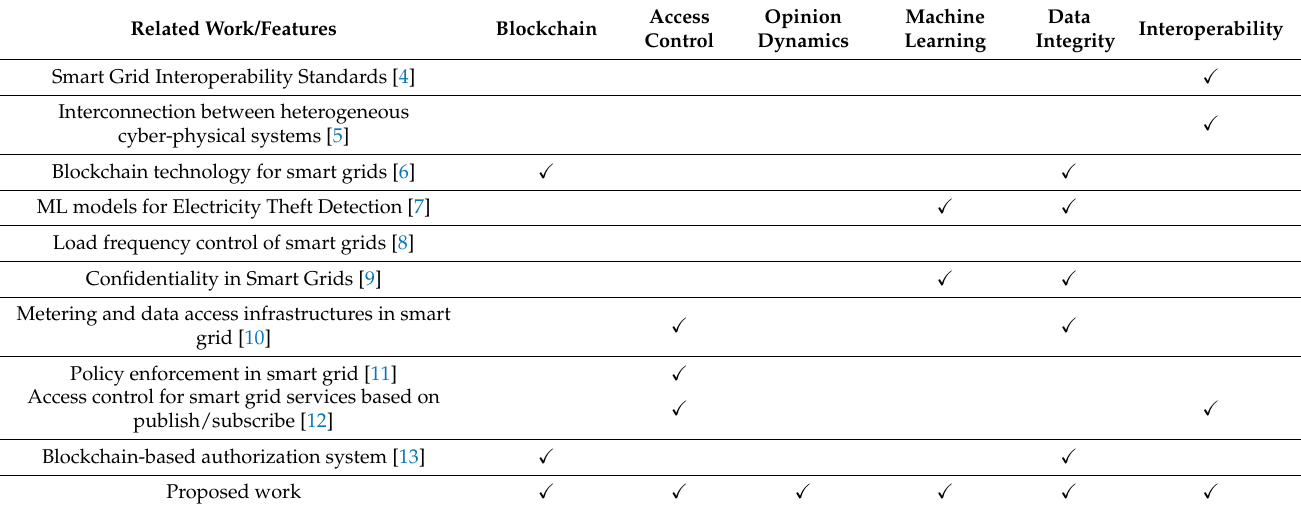
Table 1. SealedGRID features. (cid:88) the enabled features of the system.